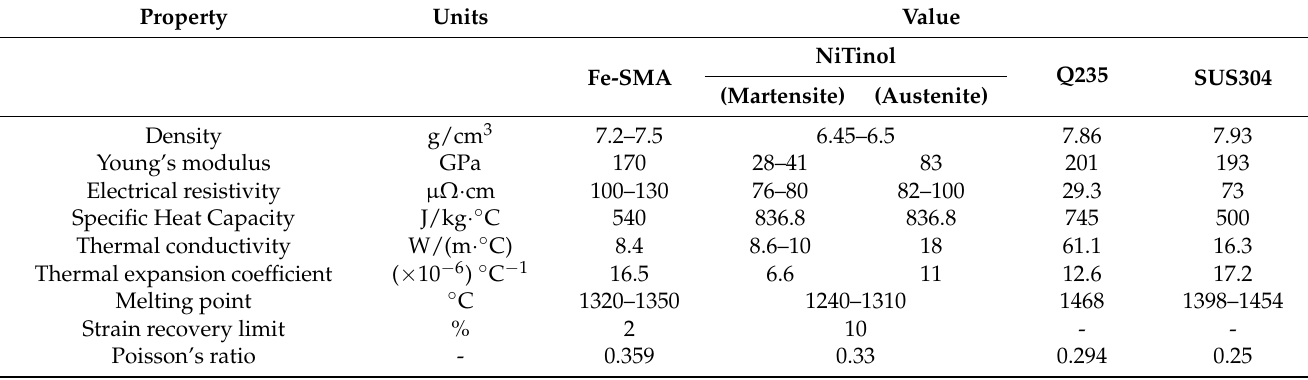
Table 1. Physical properties for SMAs and conventional structural steels